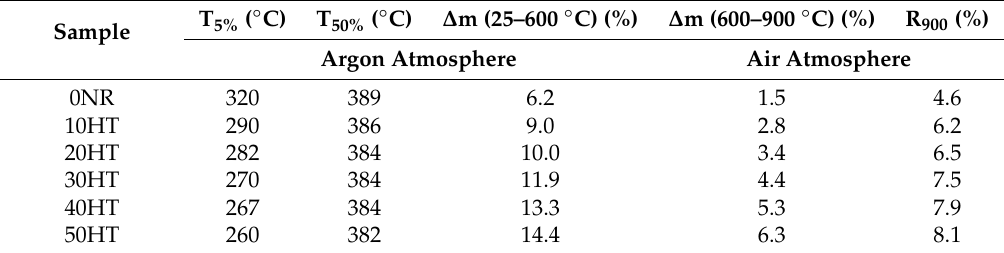
Table 3. Decomposition temperatures at 5% (T 5% ), 50% (T 50% ), total mass loss during decomposition of vulcanizates and residue after combustion (R 900 ).